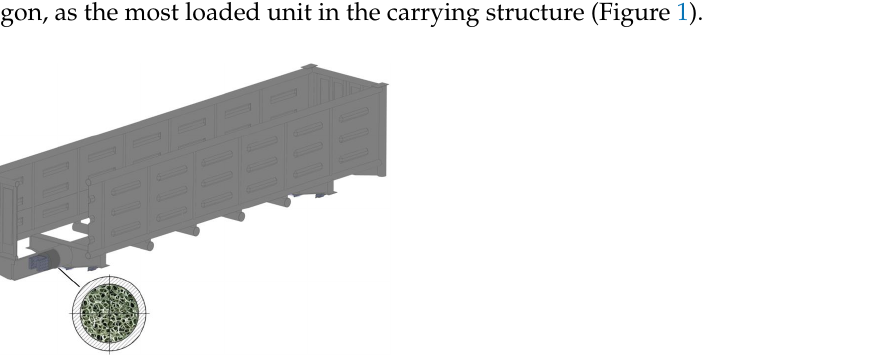
Figure 2. Design diagram of open wagon under shunting impacts.   